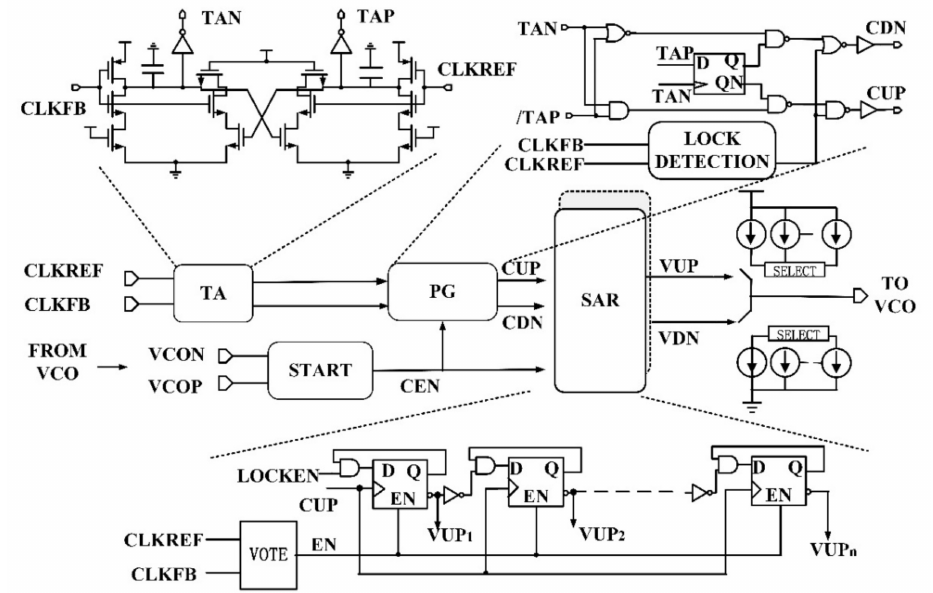
Figure 4. The digital adaptive mismatch calibration